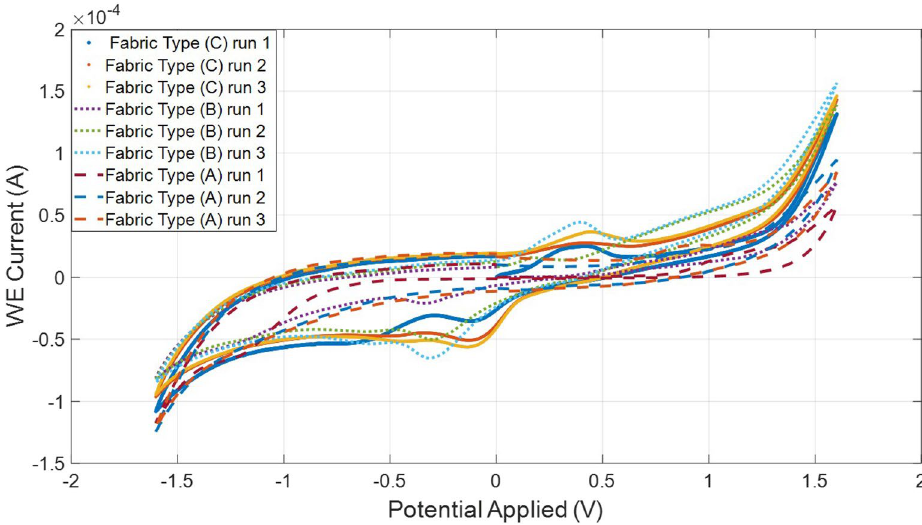
Figure 11. Measurements obtained when testing 30 mg/mL of BSA solutions on SPE design (C) and conducting three cycles on the three types of fabric.